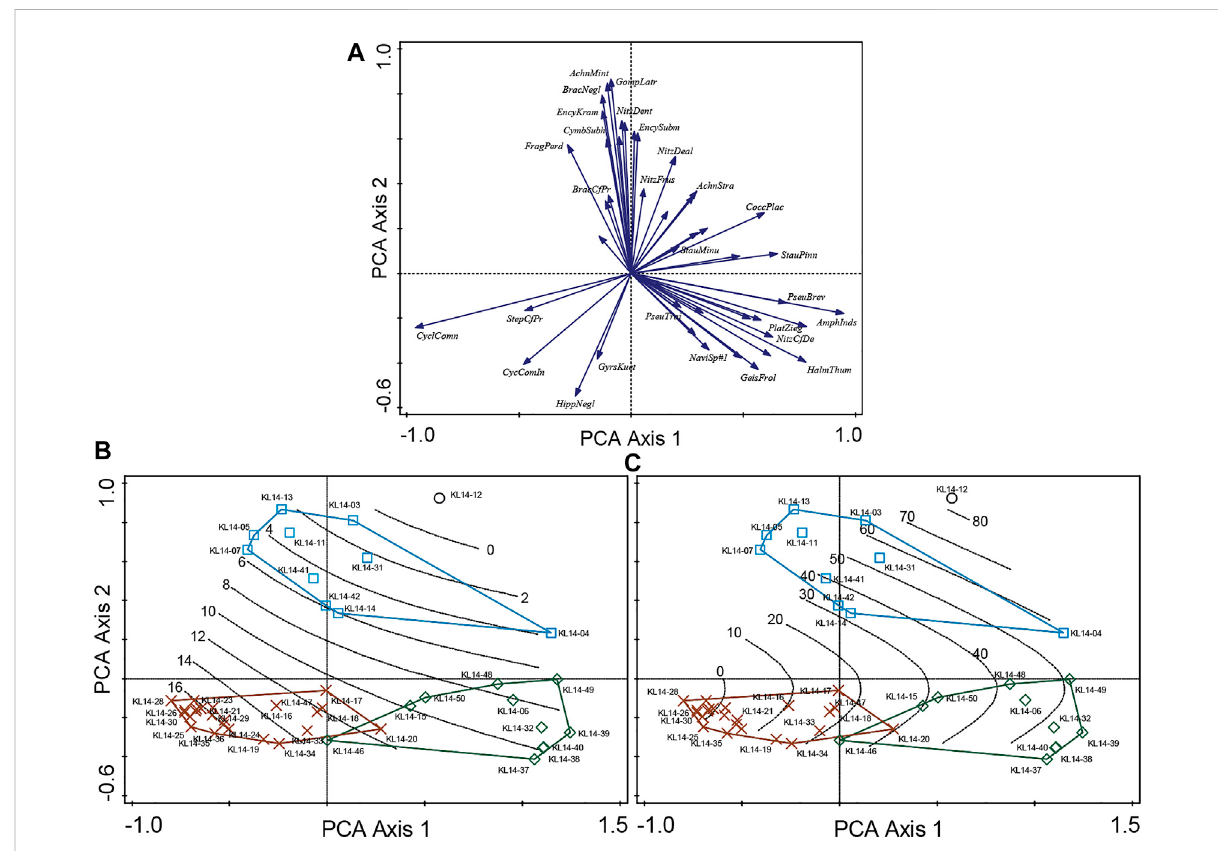
FIGURE 5 Principalcomponentsanalysis(PCA)ofthesurfacesedimentdiatomdata. (A) ,showsthe45mostabundantspeciesinthedataset(arrows). (B,C) showthesamplescodedaccordingtotheirTWINSPANgroupingsaswellasthecontourplots basedongeneralizedadditivemodels(GAM)forwater depth and the percentage of sand in the samples, respectively. In this analysis all 45 surface sediment samples are included.